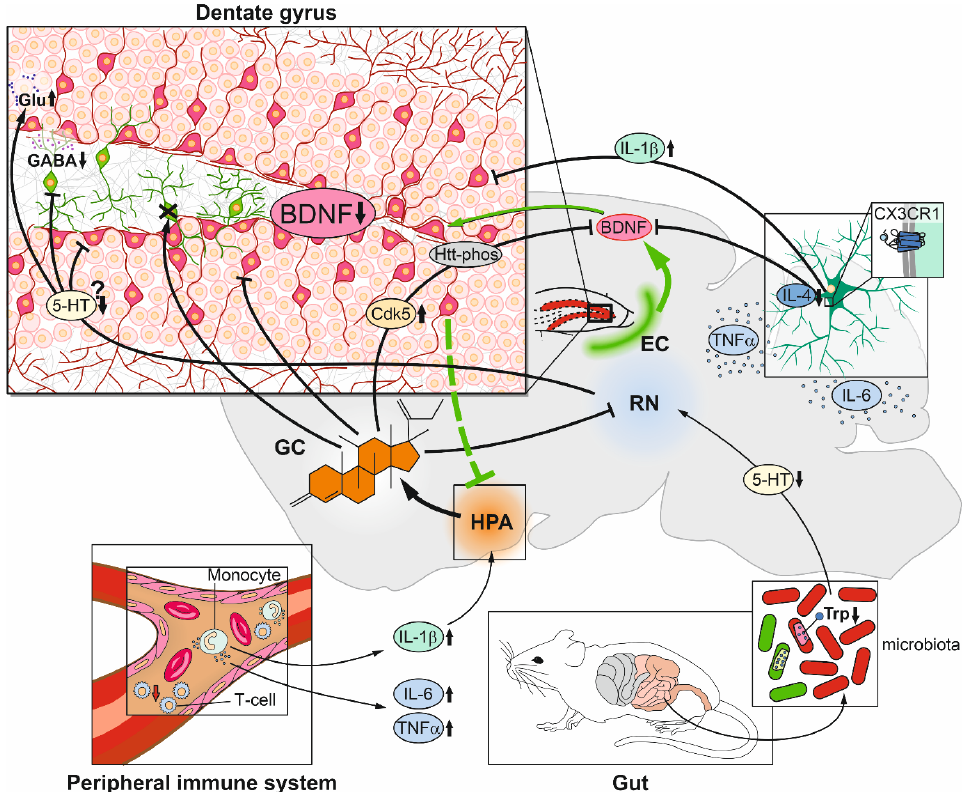
Figure 2. Schematic integrated view of mechanisms conferring negative regulation of adult hippocampal neurogenesis by chronic stress. Hypothalamic–pituitary–adrenal-(HPA) axis controls stress-induced glucocorticoid (GC) release, which exerts a direct negative effect on adult neural stem cells and their progeny (red cells) in the dentate gyrus. In reverse, adult-born neurons exert negative feedback on the HPA axis (green dashed line). HPA axis can get activated by increased interleukin-1 β (IL-1 β ) released by peripheral monocytes. Under conditions of chronic stress, the gut microbiome can change to low tryptophan (Trp) metabolizing microbiota, mainly targeting the serotonergic system of the raphe nuclei (RN), leading to serotonin (5-HT) reduction. 5-HT-reduction might also be due to direct GC effects on raphe neurons, with control of hippocampal glutamatergic and GABAergic release in the dentate gyrus, leading to high glutamate (Glu) and reduced GABA levels. Low GABA is further caused by a GC-mediated decrease of hilar interneurons (green cells). In addition, reduced 5-HT and dysregulation of 5-HT receptors (5HT 1A R and 5HT 4 R, not depicted) on mature granule cells (light red cells) leading to reduced BDNF availability might be implicated in the stress-induced reduction of neurogenesis. BDNF reduction is also central, due to other mechanisms: (1) Decreased axonal transport of BDNF vesicles from the entorhinal cortex (EC; green arrows for vesicular BDNF-transport), due to hyperphosphorylated huntingtin (Htt-phos) mediated by GC-induced cyclin-dependent kinase 5 (Cdk5); (2) decrease in interleukin-4 (IL-4) sensed by microglia. Moreover, microglia directly inhibit adult neural stem cells and their progeny, (1) through signaling activated by binding of the chemokine CX3CL1 to CX3CR1, which is exclusively expressed on microglia, and (2) by the secretion of IL-1 β . Increased interleukin-6 (IL-6) and tumor necrosis factor- α (TNF α ) make up the inflammatory milieu of the brain, but are not necessarily released by microglia.